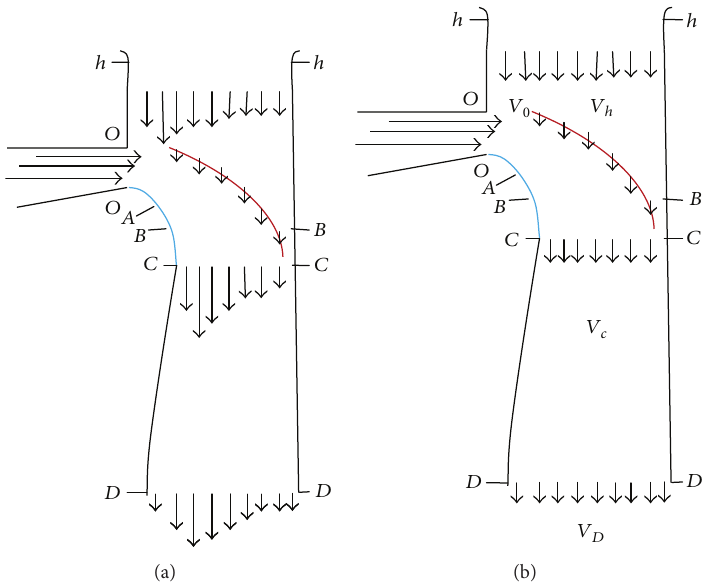
Figure 2: Coand˘a ejector with (a) nonuniform speed distribution and (b) uniform speed distribution.